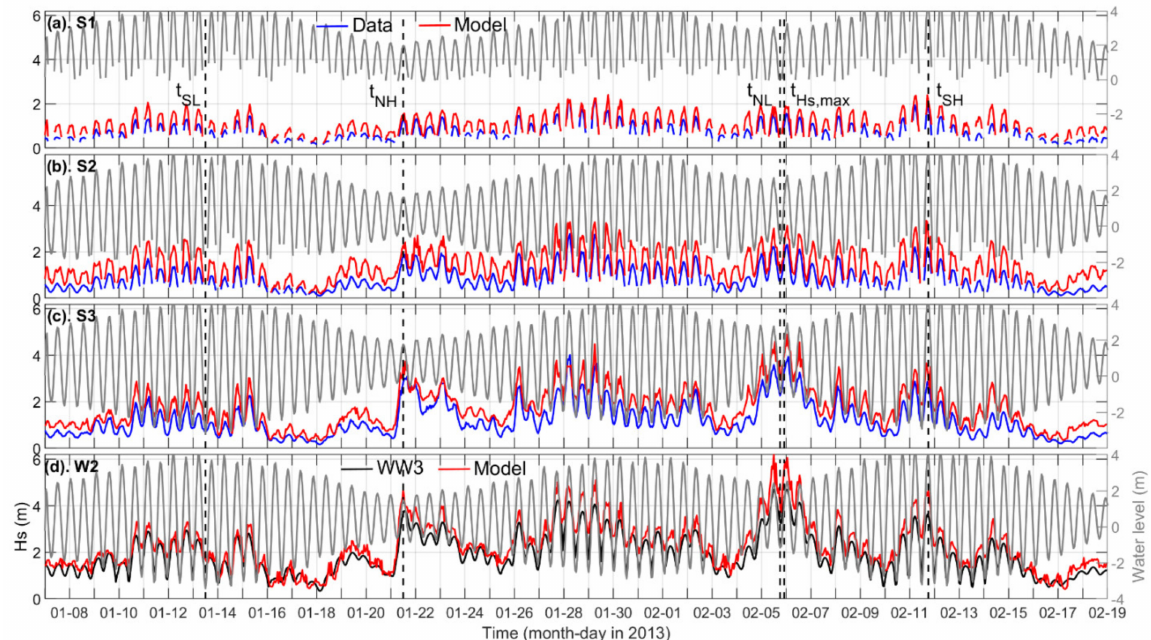
Figure 7. Comparison of the measured (blue) and the simulated (red) wave heights at the pressure sensor locations: ( a ) S1, ( b ) S2, and ( c ) S3 (see Figure 6). ( d ) Comparison of wave heights at W2 from WW3 (black line) and the present Delft3D model (red line). The gray line indicates the simulated water levels and the vertical dashed lines indicate the selected dates: t SL : spring-low, t NH : neap-high, t NL : neap-low, t Hs,max : peak storm wave height, and t SH : spring-high